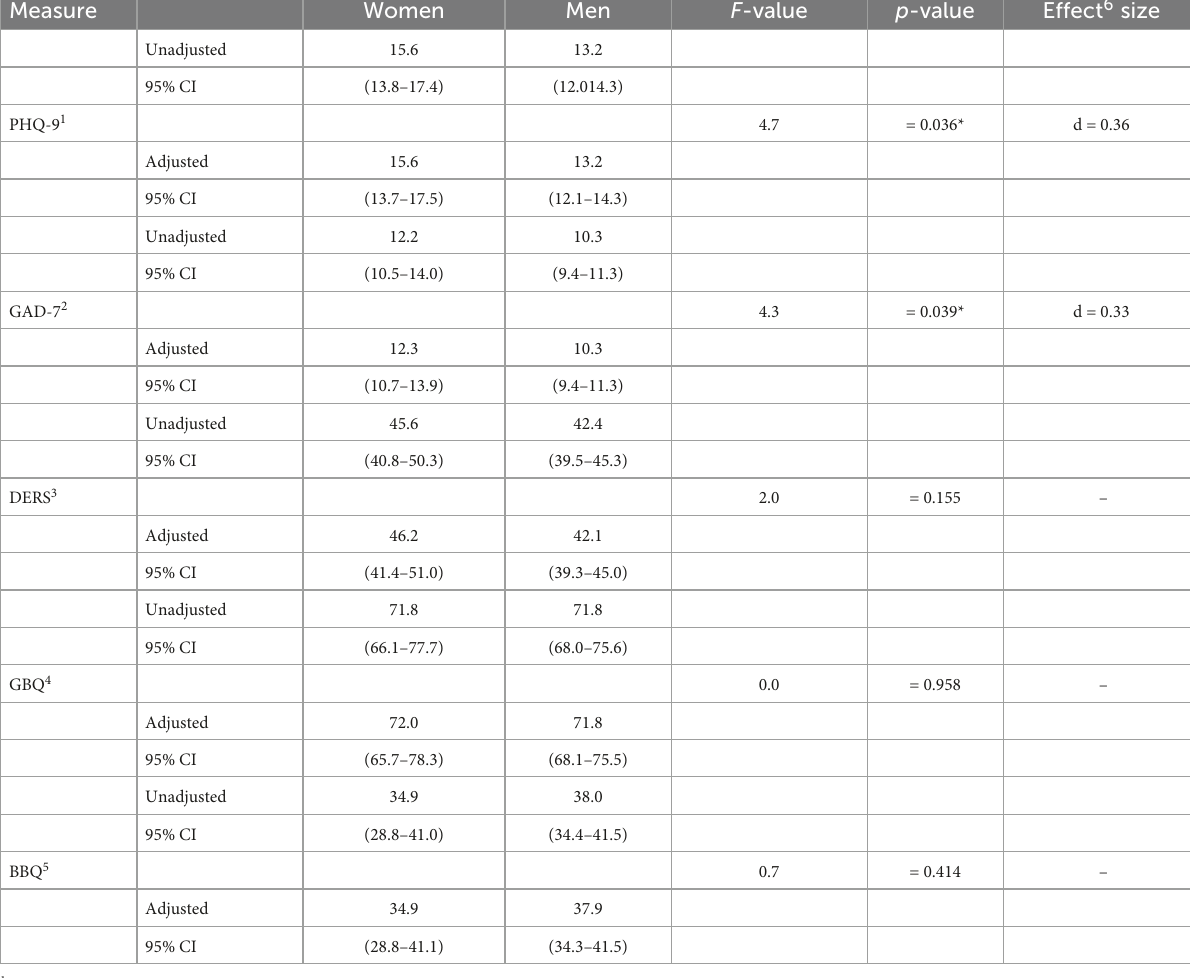
TABLE 3 ANCOVA results between women and men for depression (PHQ-9), anxiety (GAD-7), emotional instability (DERS), gambling related cognitive distortions, (GBQ-SE), and quality of life (BBQ): p -values, means, and adjusted means with 95% confidence intervals.